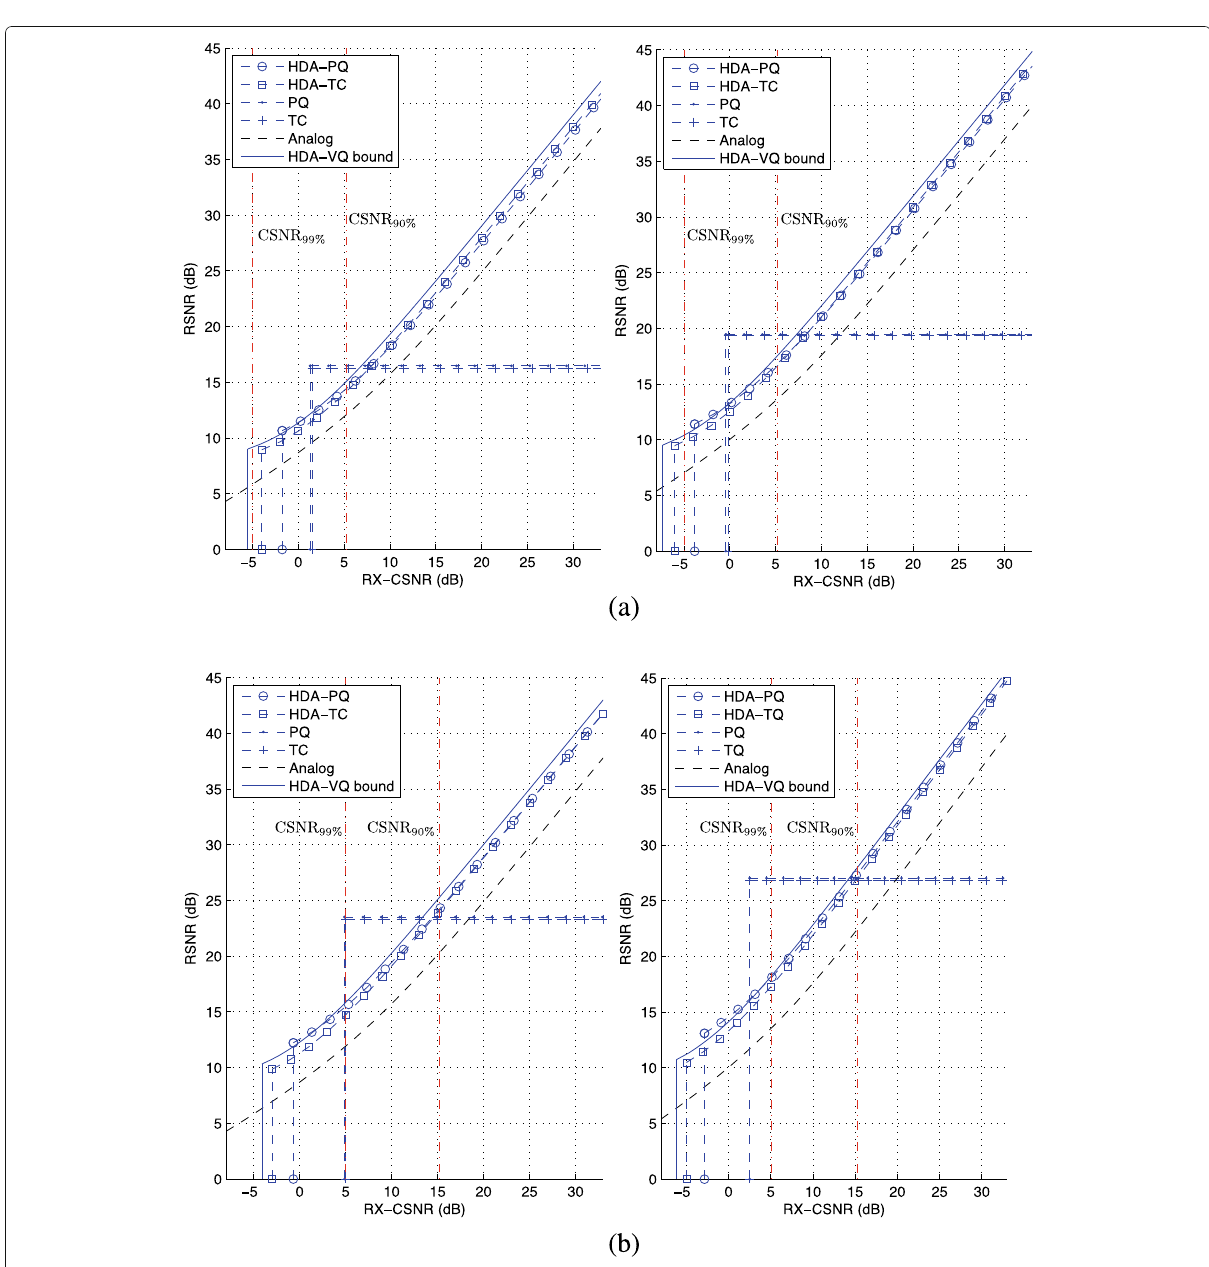
Fig. 4 Experimental RSNR of asymptotically optimal designs as a function of RX-CSNR for GM(0.9) source. HDA-PQ prediction order is 1, and HDA-TQ transform block size is 8. a ¯ θ = 15 dB, left : b = 3, right : b = 5. b ¯ θ = 25 dB, left : b = 3, right : b =